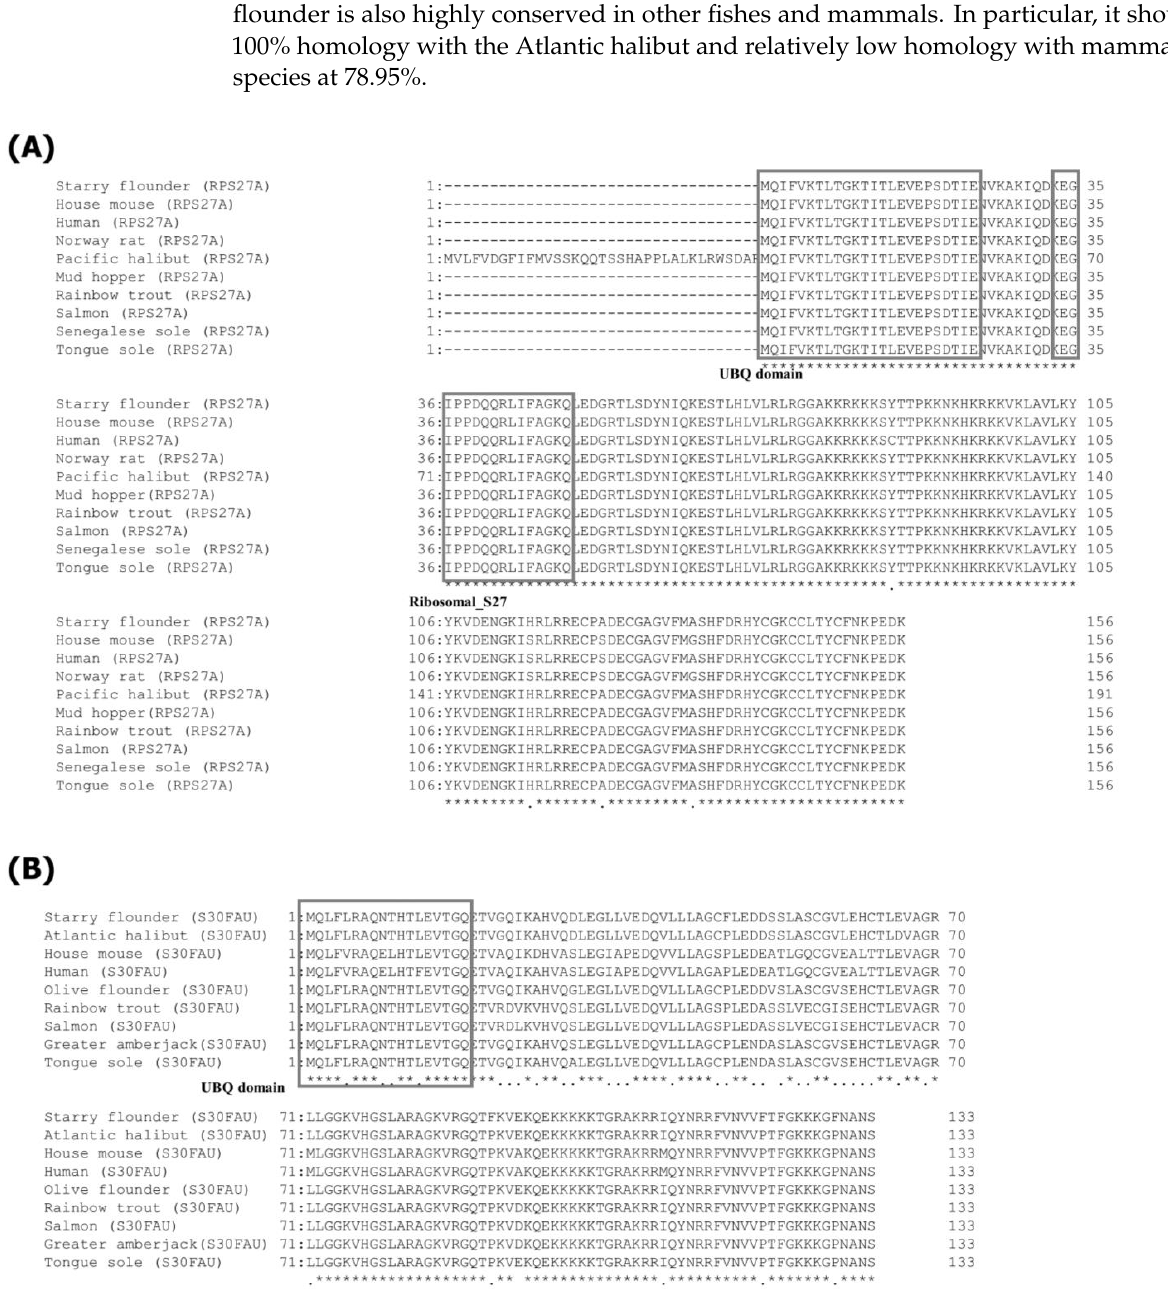
Figure 2. Multiple sequence alignment analysis of starry flounder RPS27A ( A ) and S30FAU ( B ) sequence with other species amino acid sequences. An asterisk denotes the presence of homology in all amino acid sequences, while a dot signifies the absence of homology in all or part of the sequence. NCBI accession numbers of dicentracin are as follows: house mouse ( Mus musculus ), NP_001029037.1; human ( Homo sapiens ), AAH53371.1; Norway rat ( Rattus norvegicus ), NP_001292372.1; Pacific halibut ( Hippoglossus stenolepis ), XP_035028116.1; mud hopper